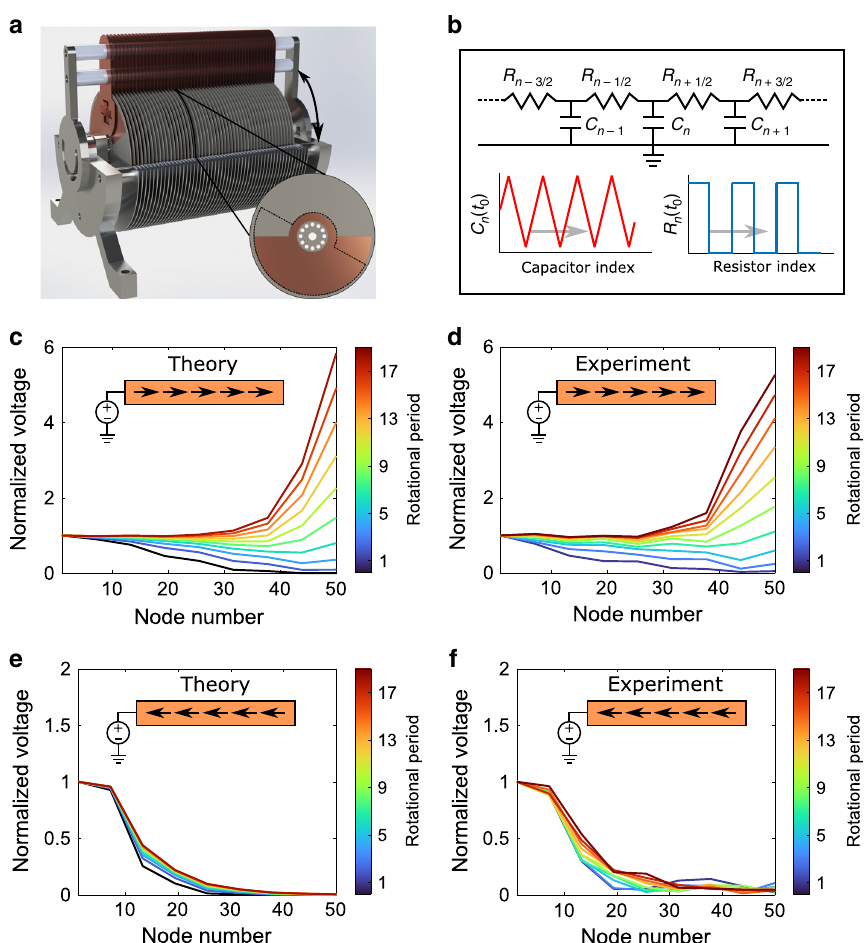
Fig. 2 Theoretical and experimental demonstration of the temporal dynamics of the spatiotemporally varying diffusive medium. a Design of the experimental setup for the spatiotemporal metastructure with an inset showing the metallization of one of the 51 disks. The dotted lines show the relative position of the neighboring disk (rotated by angle π = 6). The relative phase between the connections and the capacitors can be modi fi ed by rotating the top bar along the direction of the arrow. b Circuit representation of the chain of disks connected via angle-controlled switches and interdigitated by grounded stators to vary their capacitance in time. c Time evolution of the time-averaged voltage dictated by the analysis of the equivalent circuit for the realized metamaterial for ϕ ¼ π = 3. d Experimentally measured time-averaged voltages along the sample for the same con fi guration as c . e Similar to c but f or ϕ ¼ (cid:2) π = 3. f Experimentally measured time-averaged voltages along the sample for the same con fi guration as e